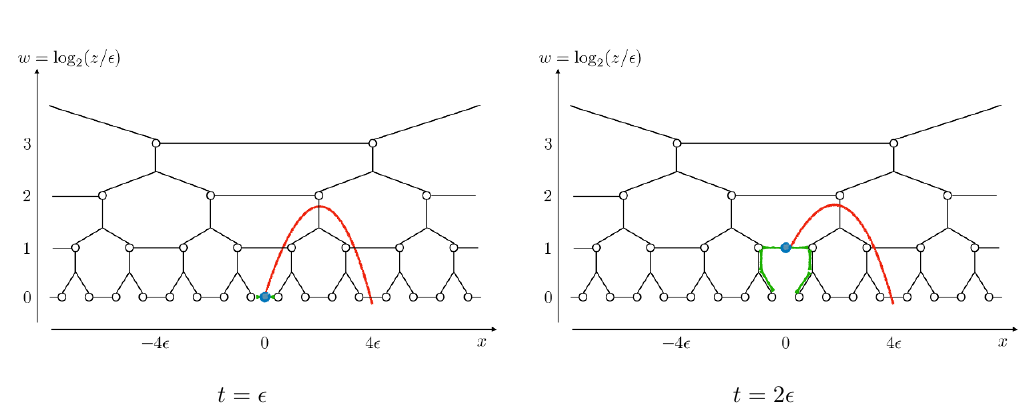
Figure 25 . Time evolution of the tensor network after splitting quench. The red curve shows the minimum curve in the bulk. The blue dot and green curve are dual to the falling particle and boundary surface Q . Here, A = f x j x 2 (0 ; 4 (cid:15) ) g